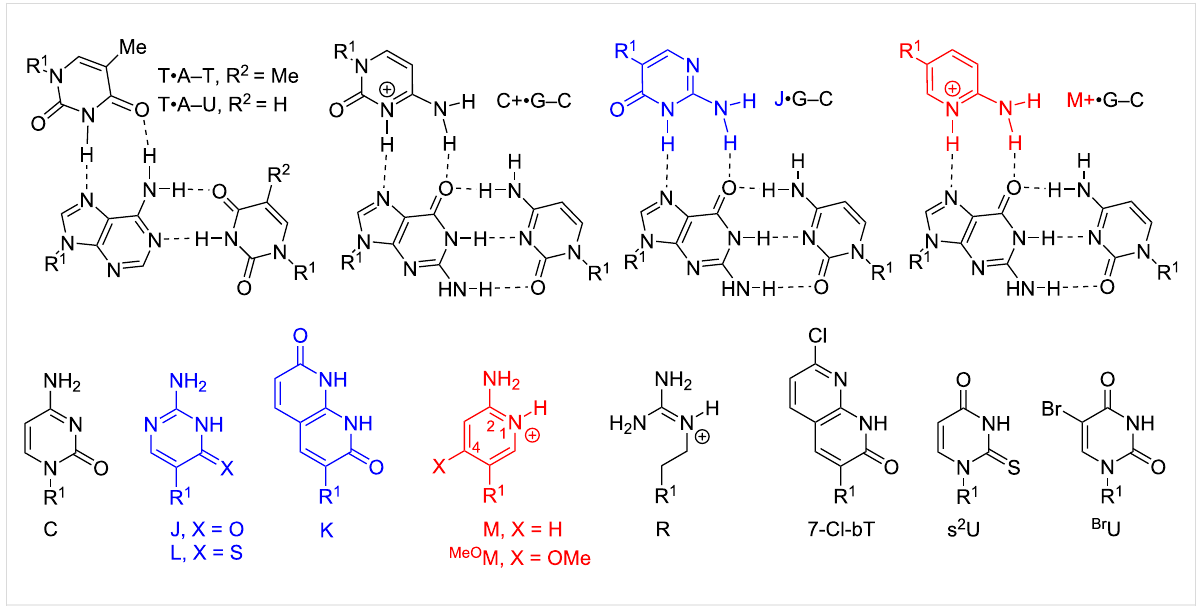
Figure 6: Structures of modified nucleobases in PNA to improve Hoogsteen hydrogen bonding to guanine and adenine. R 1 denotes DNA, RNA, or PNA